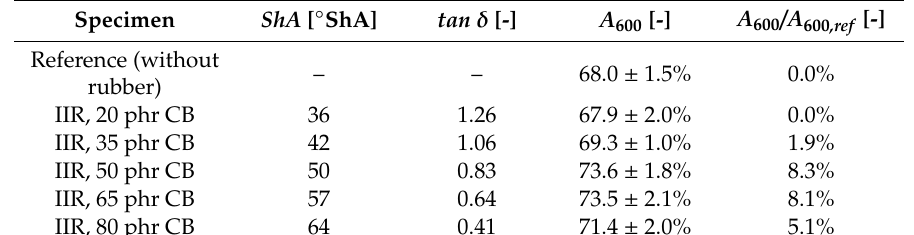
Table 6. Mean values of energy absorption A with a standardized impact velocity v 0 of 600 m/s for the investigated configurations using IIR formulations with varying carbon black (CB) content.